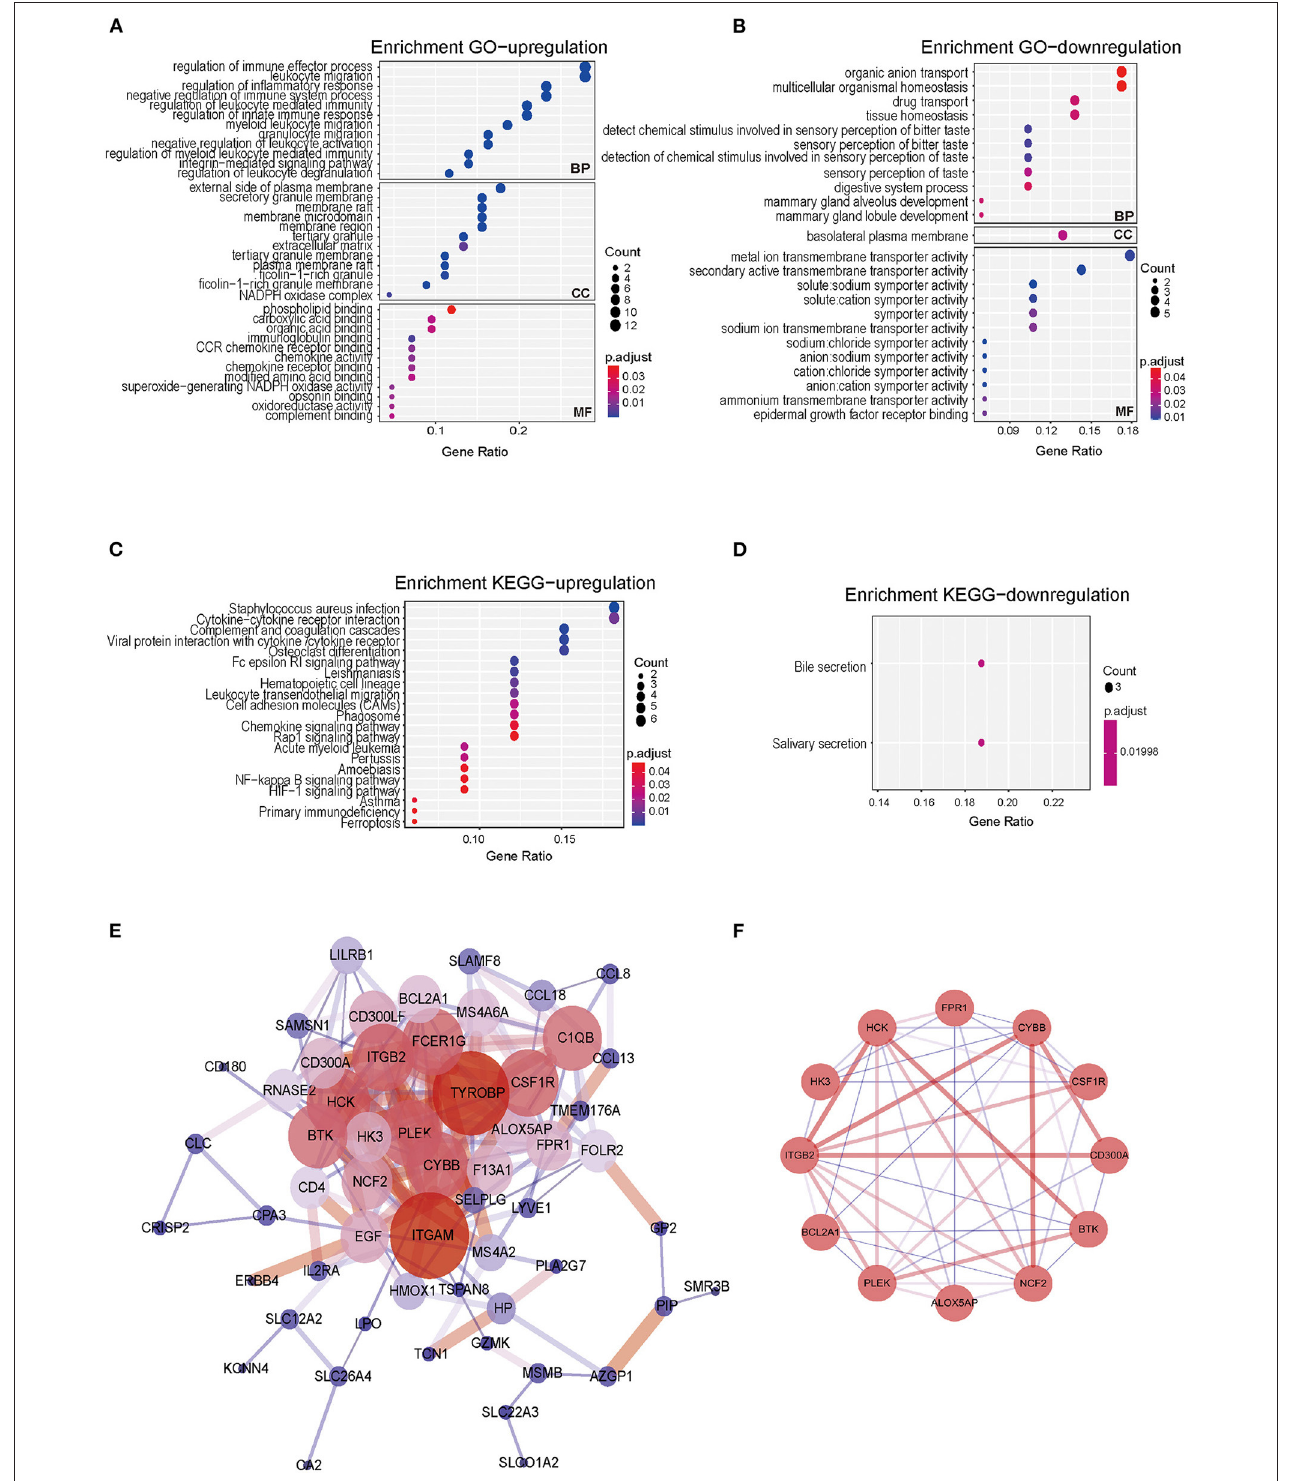
FIGURE 3 | Gene Ontology, KEGG pathway, PPI network of co-DEGs, and hub gene identification analyses in CRSwNP. (A,B) Bubble chart showing enriched GO terms for (A) upregulated co-DEGs and (B) downregulated co-DEGs. (C,D) Bubble chart showing enriched KEGG pathways for (C) upregulated co-DEGs and (D) downregulated co-DEGs. P -values < 0.05 and q -values < 0.2 were considered statistically significant. (E) PPI networks of the 76 co-DEGs from the four GEO datasets of CRSwNP. The node color represents the degree of proteins, and the edge color represents the combined score of proteins. Red represents high, and blue represents low. (F) The hub genes of PPI